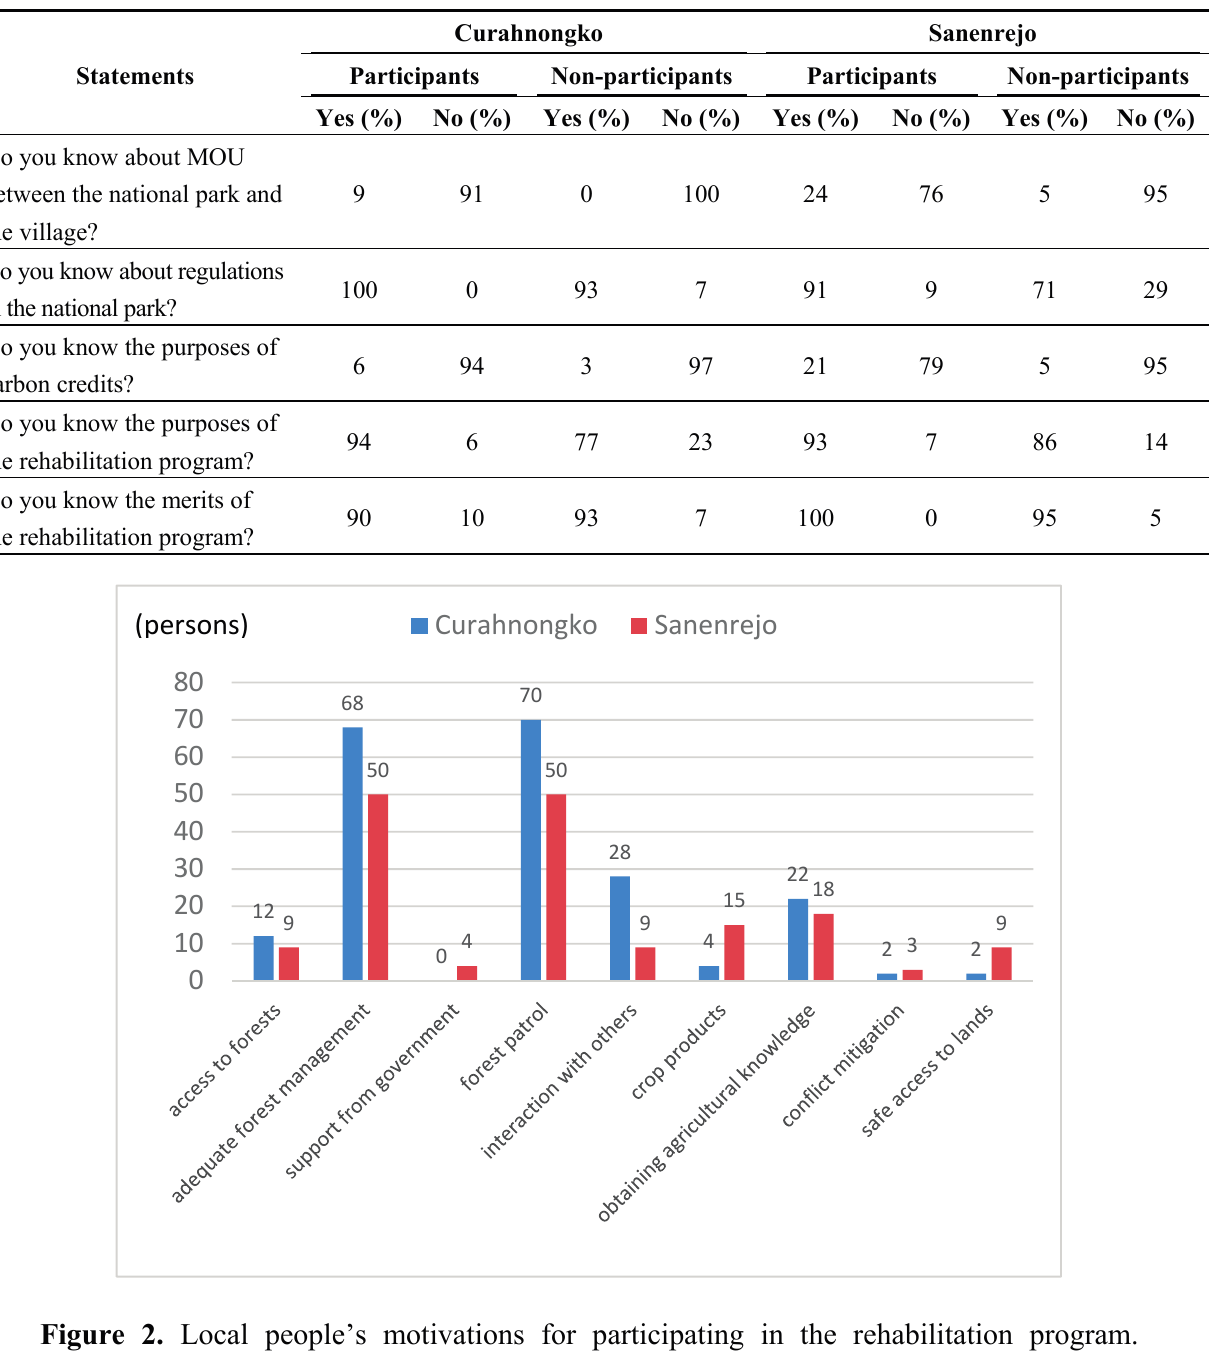
Table 3. Local awareness of the rehabilitation program.